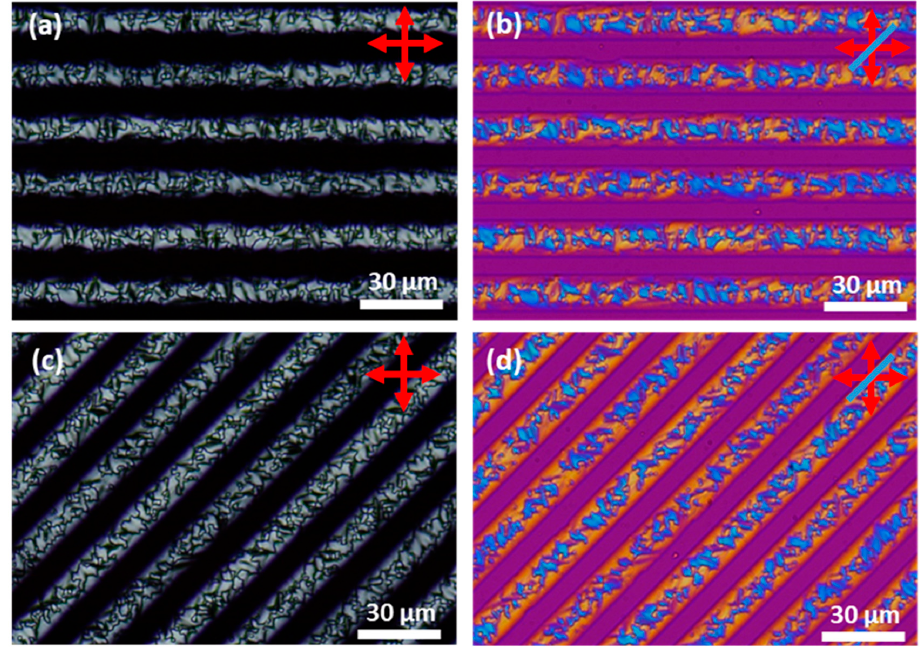
Figure 12. POM images for de ‐ wetted stripes of the LC E7 containing 8.2% of the chiral dopant S1011. Hydrophilic stripes 25 μ m wide. Hydrophobic stripes 10 μ m wide. ( a ) Crossed polarisers with the stripes parallel to one polarisation direction. ( b ) With an added wave plate. ( c ) Crossed polarisers with the stripes at − 45° to the vertical. ( d ) With an added wave plate. The blue line indi ‐ cates the orientation of the slow axis of the compensator.